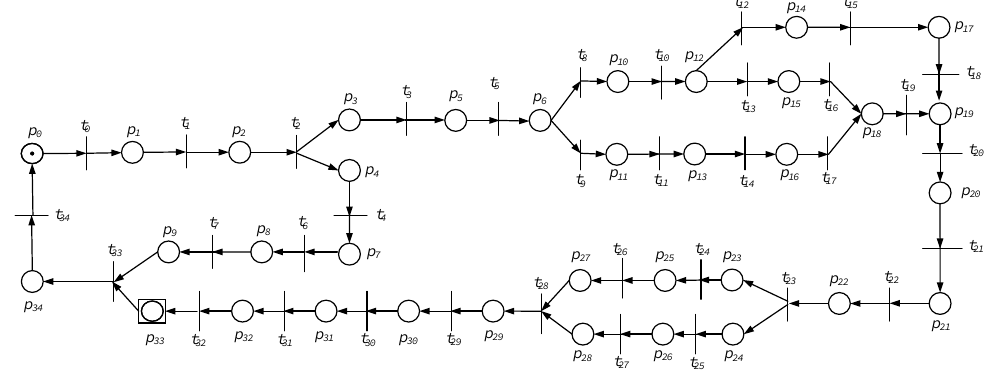
Figure 15. Petri net G .